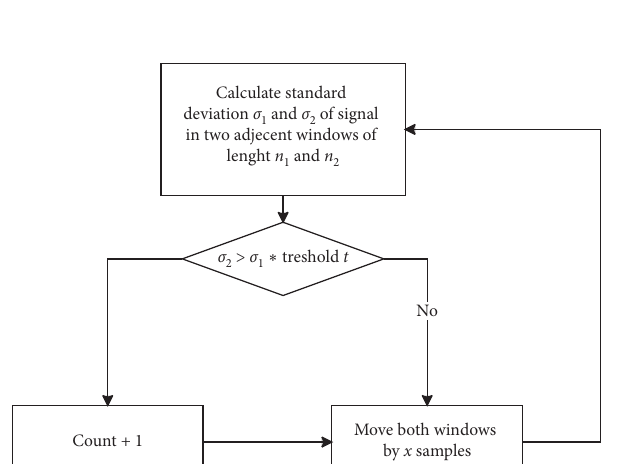
Figure 8: Organigramme of the applied algorithm.